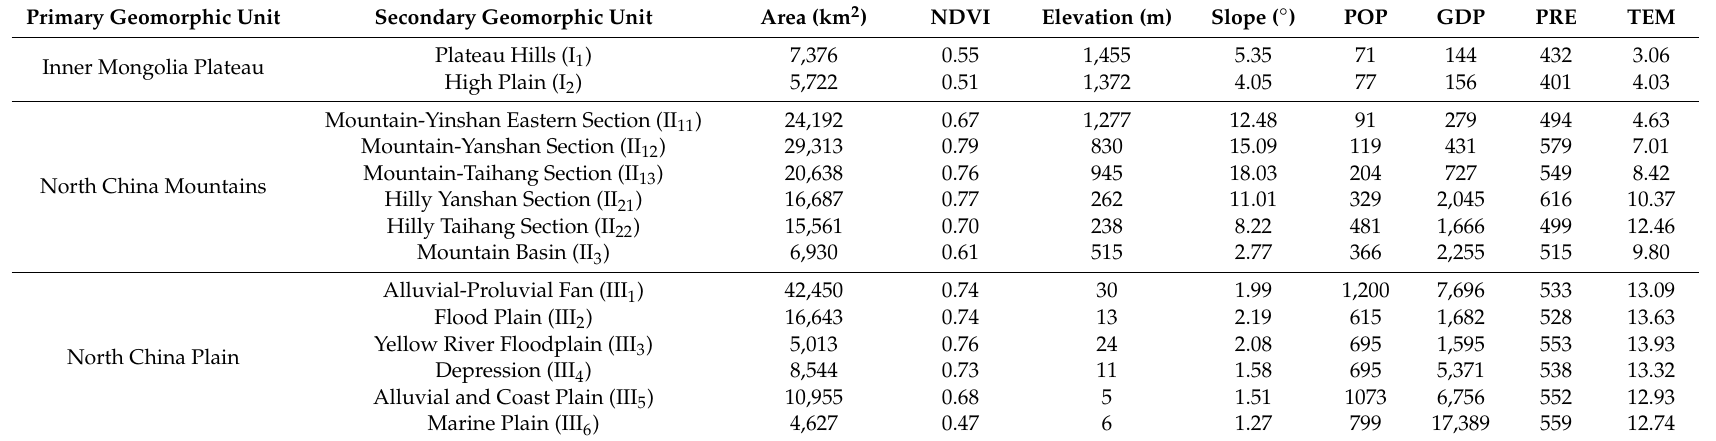
Table A1. Basic information of each geomorphic